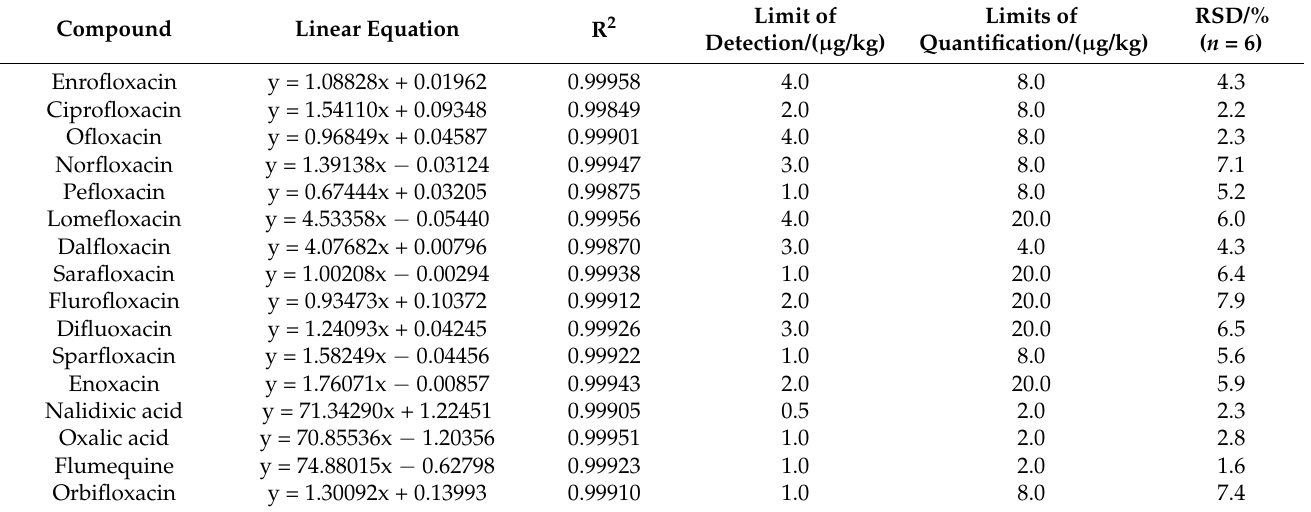
Table 1. Linear equation, limits of detection and quantification, precision of 16 quinolones.